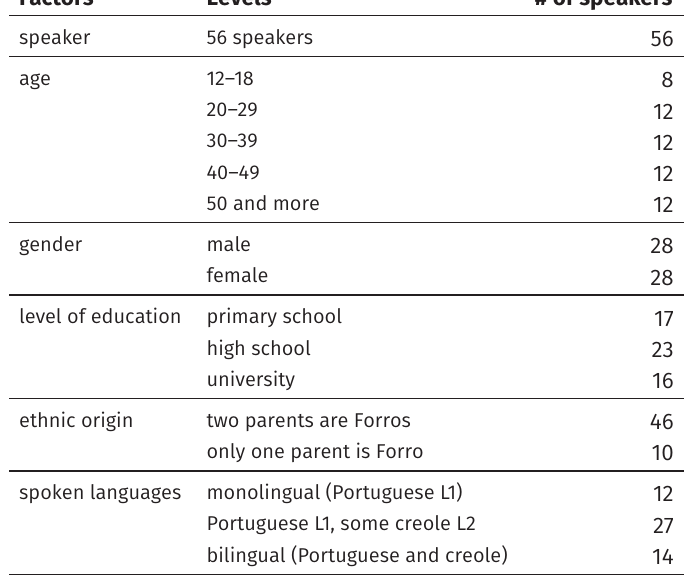
Table 6: Independent social factors for coding